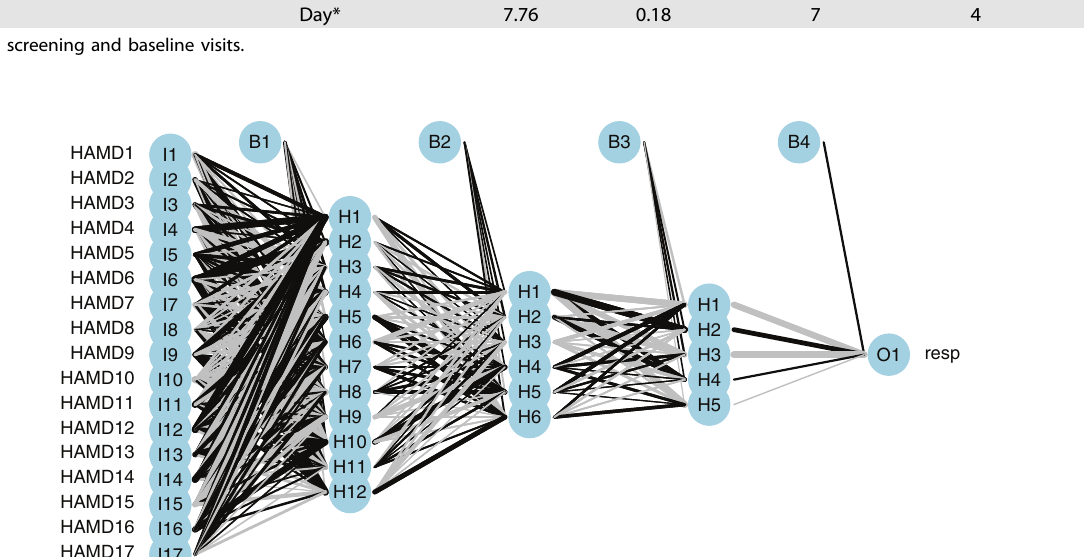
Fig. 1 ANN Analysis. Final neural network layouts for the analysis conducted using the changes from screening to baseline of the individual items of the HAMD-17 clinical scale used as potential predictors of the response (resp = response to